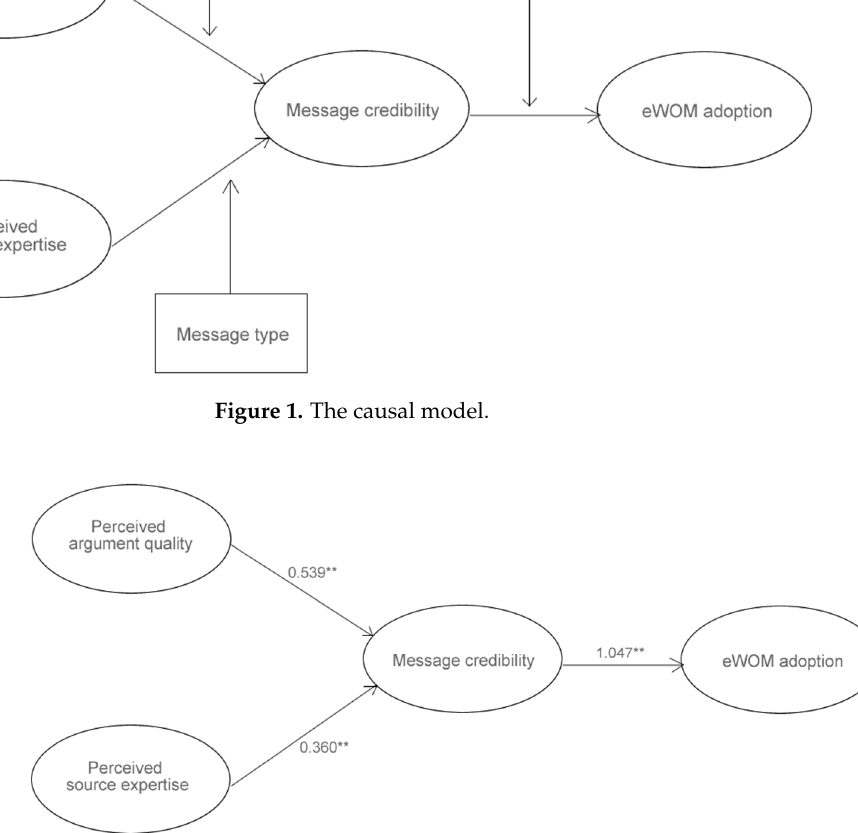
Figure 2. The path coefficients. ** the coefficients marked by ** are significant at a 0.01 level.